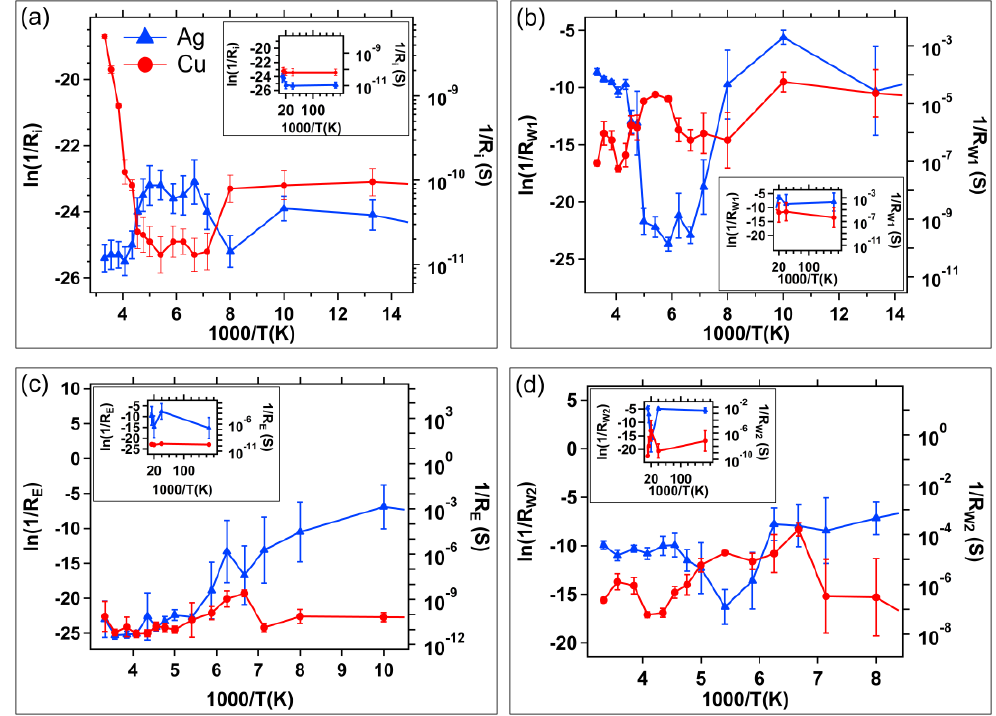
Figure 5. Average conductance versus inverse temperature for ( a ) initial resistance, R i ; ( b ) written resistance after the first write sweep, R W1 ; ( c ) erased resistance, R E ; and ( d ) written resistance after the second write sweep, R W2 . In each graph, the Cu device data is represented by circles; Ag devices as triangles. The inset of each graph is the extension of the data into the coldest temperature region. Error bars are one standard deviation.